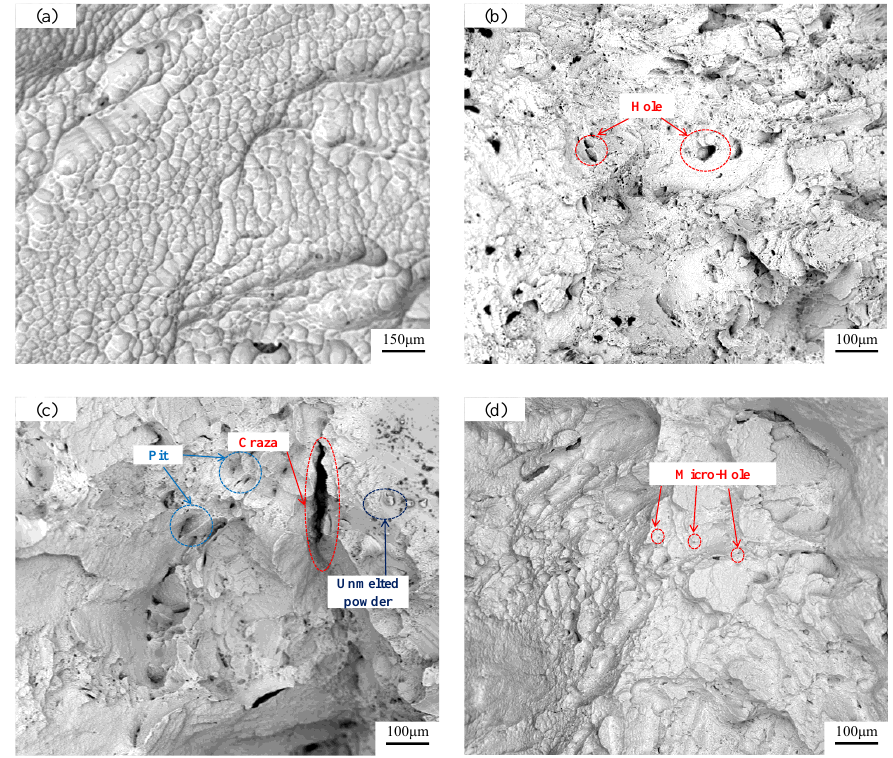
Figure 10. Tensile fracture morphology of specimens formed by different processes. ( a ) Morphology of dimple; ( b ) Laser power 300 W; ( c ) Laser power 250 W; ( d ) Laser power 300 W – 260 W evenly divided into six hierarchies.